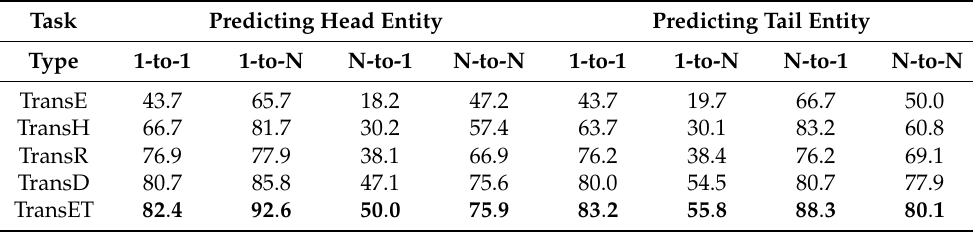
Table 4. Filtered Hits@10 score of link prediction on four types of triples